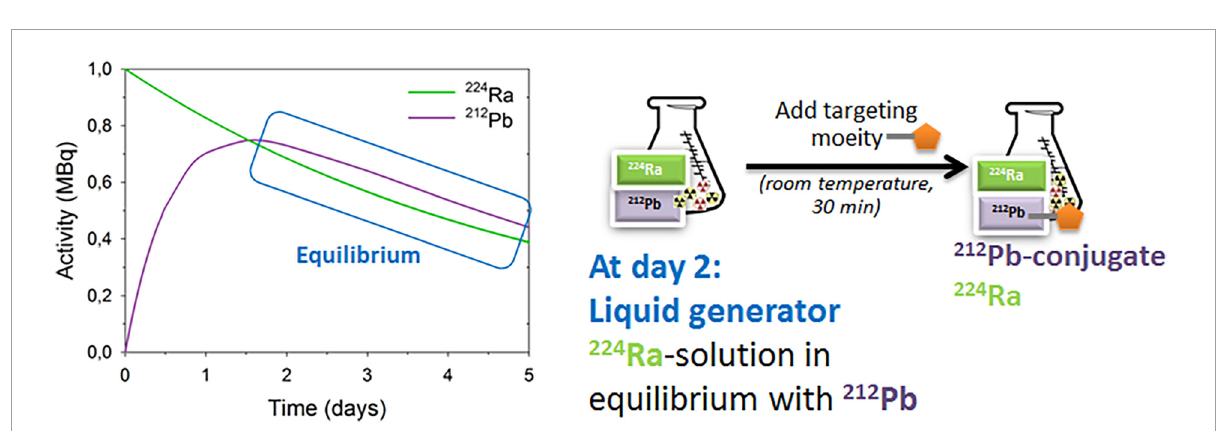
FIGURE2 The 224 Ra-liquid generator for preparation of dual alpha targeting solution. For details see references (41, 54,